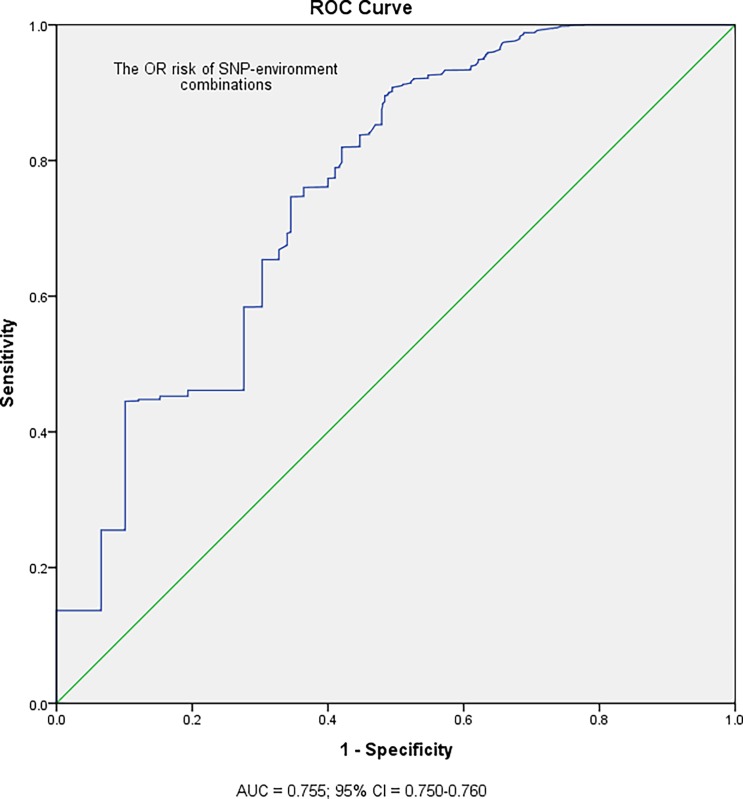
Receiver operating characteristic (ROC) curve analysis of the OR risks of SNP-environment combinations for population with oral malignant disorders.The area under the curve (AUC) = 0.755 (95% confidence interval (CI) = 0.750–0.760; p<0.001) was used to discriminate OR < 2.39 from OR ≥ 2.39 for low and high risk populations with oral malignant disorders.